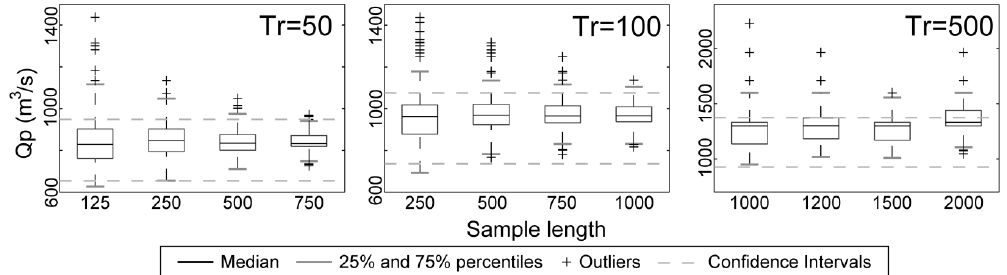
Figure 14. Median, 25% and 75% percentiles and outlier values of the peak flows associated with return periods of 50, 100 and 500 years calculated from different series length for the Corbès basin.